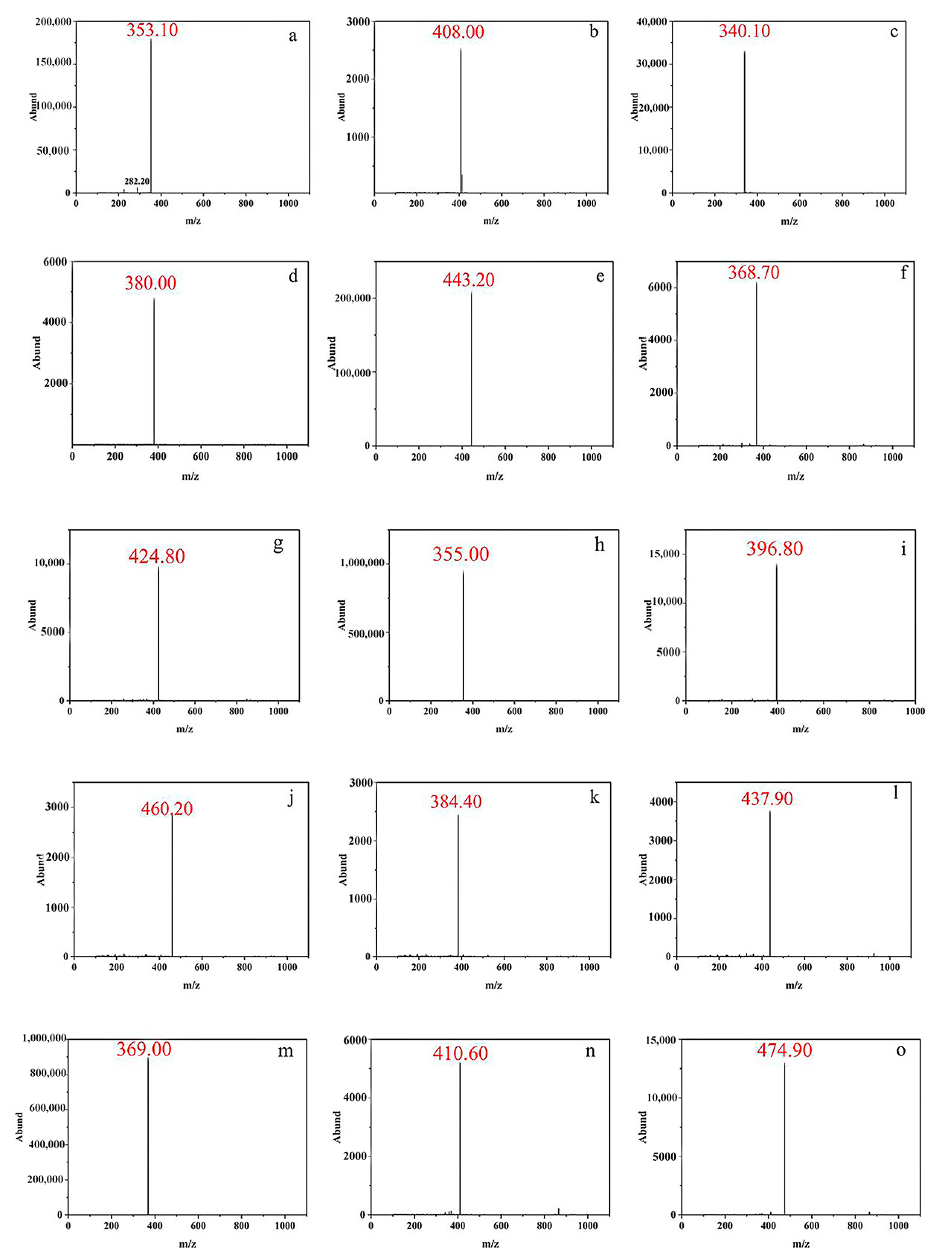
Figure 3. High-resolution mass spectra of combinations of AVA 2p with MGO ( a ), 2MGO ( b ), GO ( c ), 2GO ( d ), and 3-DG ( e ). High-resolution mass spectra of combinations of AVA 2c with MGO ( f ), 2MGO ( g ), GO ( h ), 2GO ( i ), and 3-DG ( j ). High-resolution mass spectra of combinations of AVA 2f with MGO ( k ), 2MGO ( l ), GO ( m ), 2GO ( n ), and 3-DG ( o ).